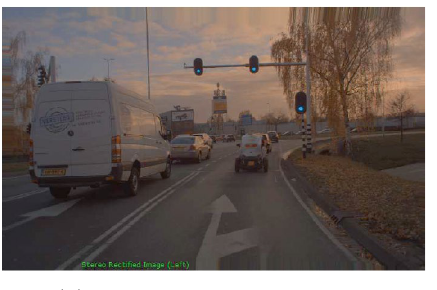
(a) Left Stereo Input Image. (b) Right Stereo Input Image.